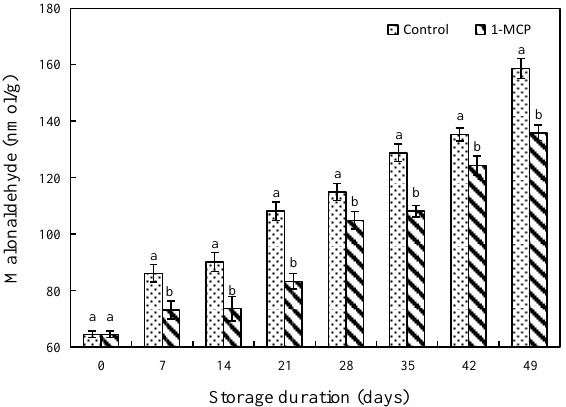
Figure 7. The effect of 1 − MCP on MDA content in the petals of ‘Dianhong’ rose during different storage periods, Different letters on the bar chart indicate significant differences among group ( p < 0.05, n = 3).